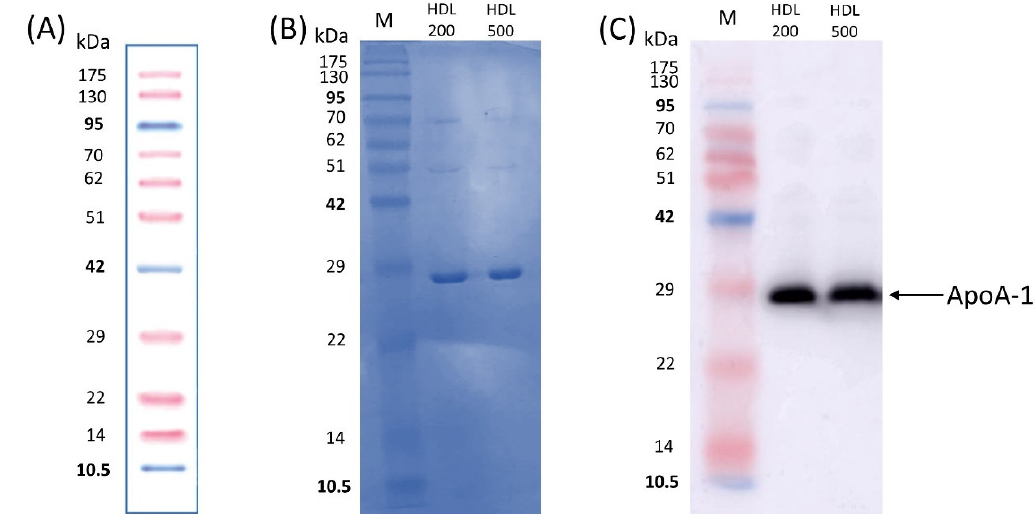
Figure 2. SDS-PAGE and Western blotting of HDLs isolated from different sample volumes. A protein ladder reference (Vivantis Technologies, Shah Alam, Selangor Darul Ehsan, Malaysia, cat no. PR0602) had 3 reference bands (10.5, 42, and 95 kDa) coupled with a blue dye for easy identification ( A ). Based on Coomassie blue G250 staining of SDS-PAGE, major bands were identified approximately at 29, 51, and 70 kDa in both HDL200 and HDL500 ( B ). A single band was identified at about 29 kDa corresponding to ApoA-1 ( C ). M = Marker of protein molecular weight.